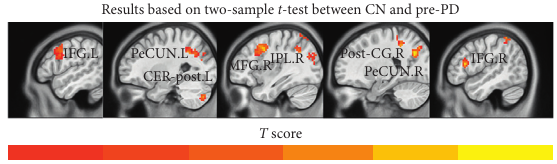
Figure 2: Comparisons of functional connectivity between CN and pre-PD ( p < 0 . 01, FDR corrected and cluster extent k > 30 voxels).